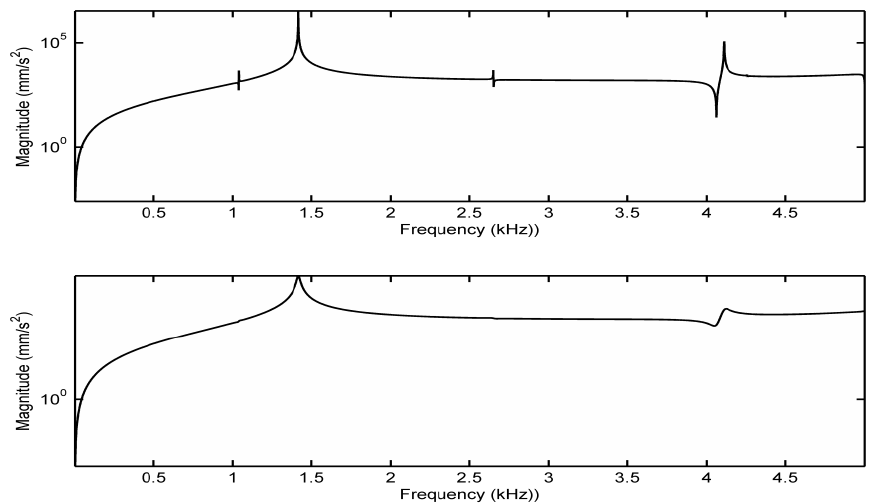
Figure 3. Frequency responses of an isolated bridge with the bridge feet clamped. Top: damping ratio 0.017% critical; Bottom: damping ratio 0.7% critical. The two peak frequencies in the bottom plot are 1,417 Hz and 4,084 Hz,